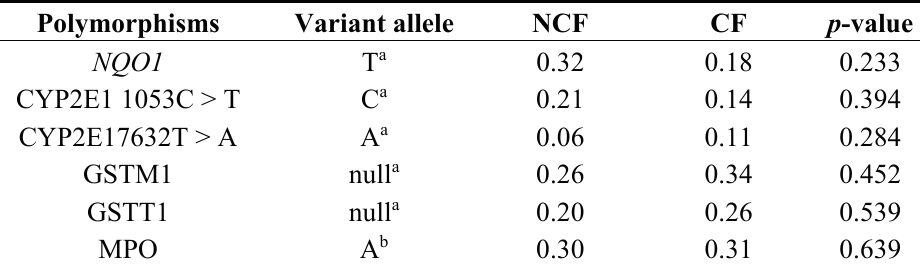
Table 4. Variant allele frequencies in NCF and